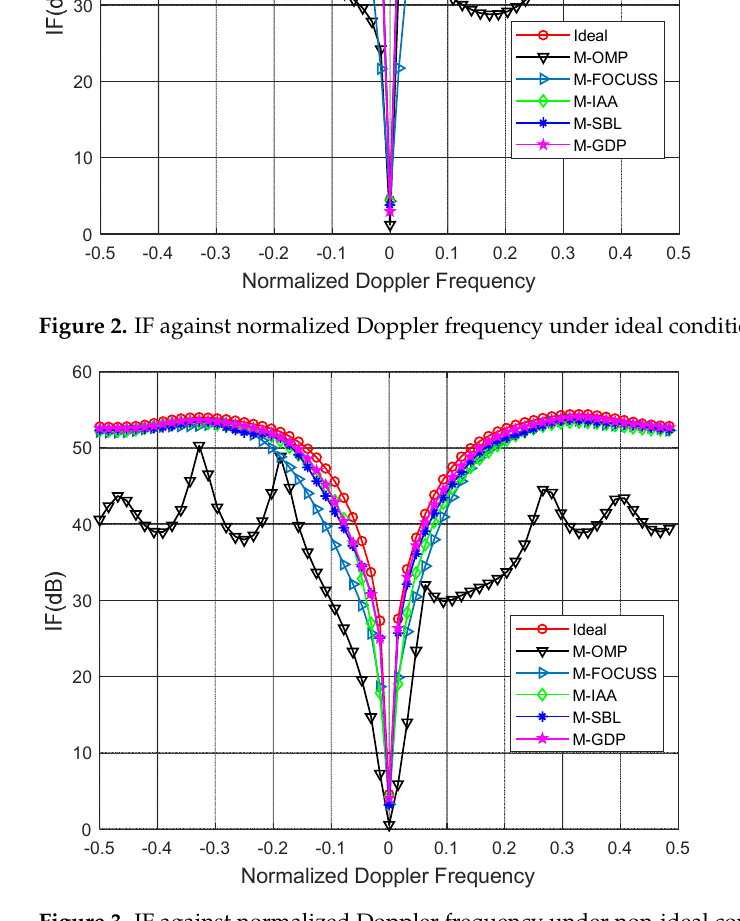
Figure 3. IF against normalized Doppler frequency under non-ideal condition.